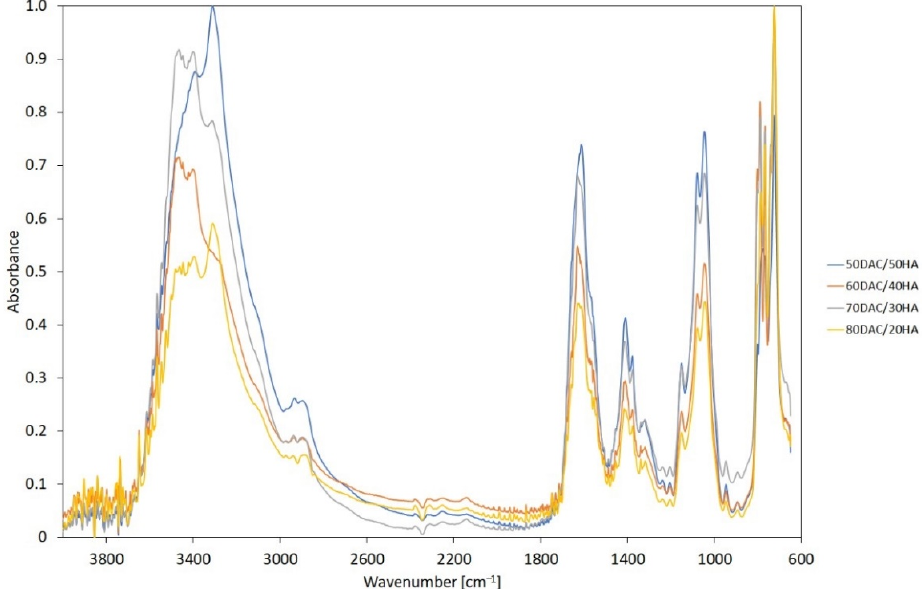
Figure 1. The FTIR-ATR spectra of dialdehyde chitosan/hyaluronic acid-based materials.